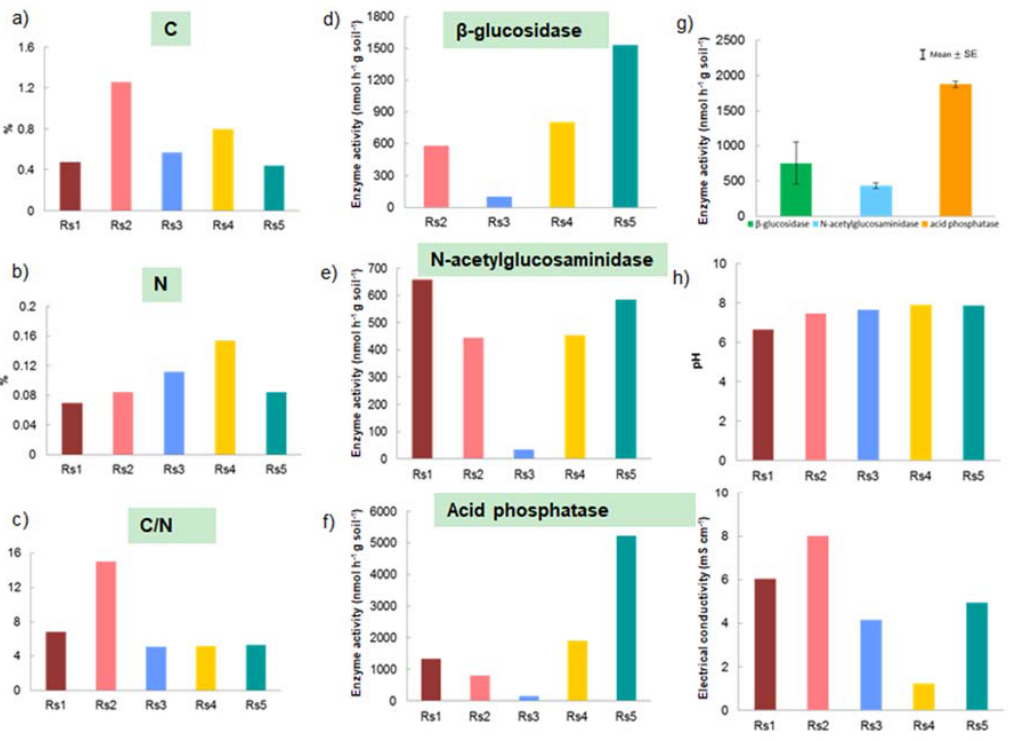
Figure 2. ( a – c ) Carbon content (C), nitrogen content (N) and carbon / nitrogen ratio (C / N); ( d – f ) β -glucosidase, N-acetylglucosaminidase and acid phosphatase enzyme activities; ( g ) mean activity of β -glucosidase, N-acetylglucosaminidase and acid phosphatase; ( h ) pH; and ( i ) electrical conductivities in the five rhizosphere soil samples